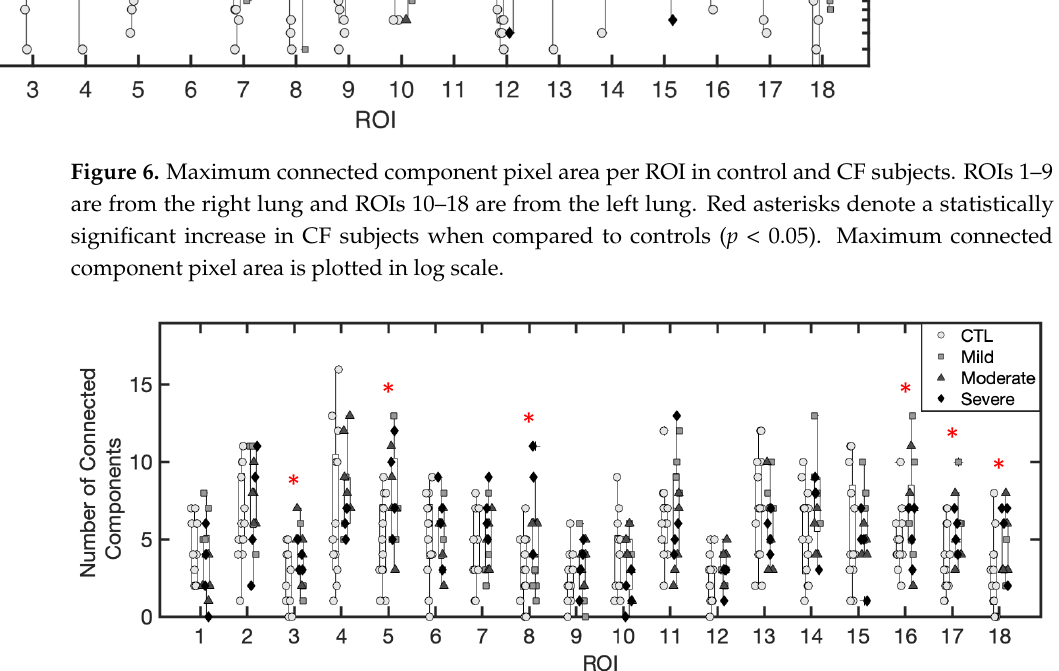
Figure 7. The number of connected components per ROI in control and CF subjects. ROIs 1–9 are from the right lung and ROIs 10–18 are from the left lung. Red asterisks denote a statistically signif- icant increase in CF subjects when compared to controls ( p < 0.05).